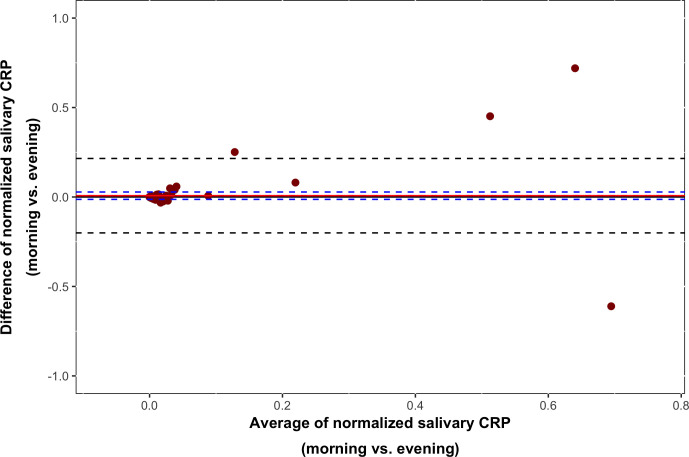
A Bland–Altman graph illustrating the level of agreement between salivary morning and evening C-reactive protein (CRP) levels based on analysis of 100 participants. The level of agreement suggested interchangeability (p=0.48).